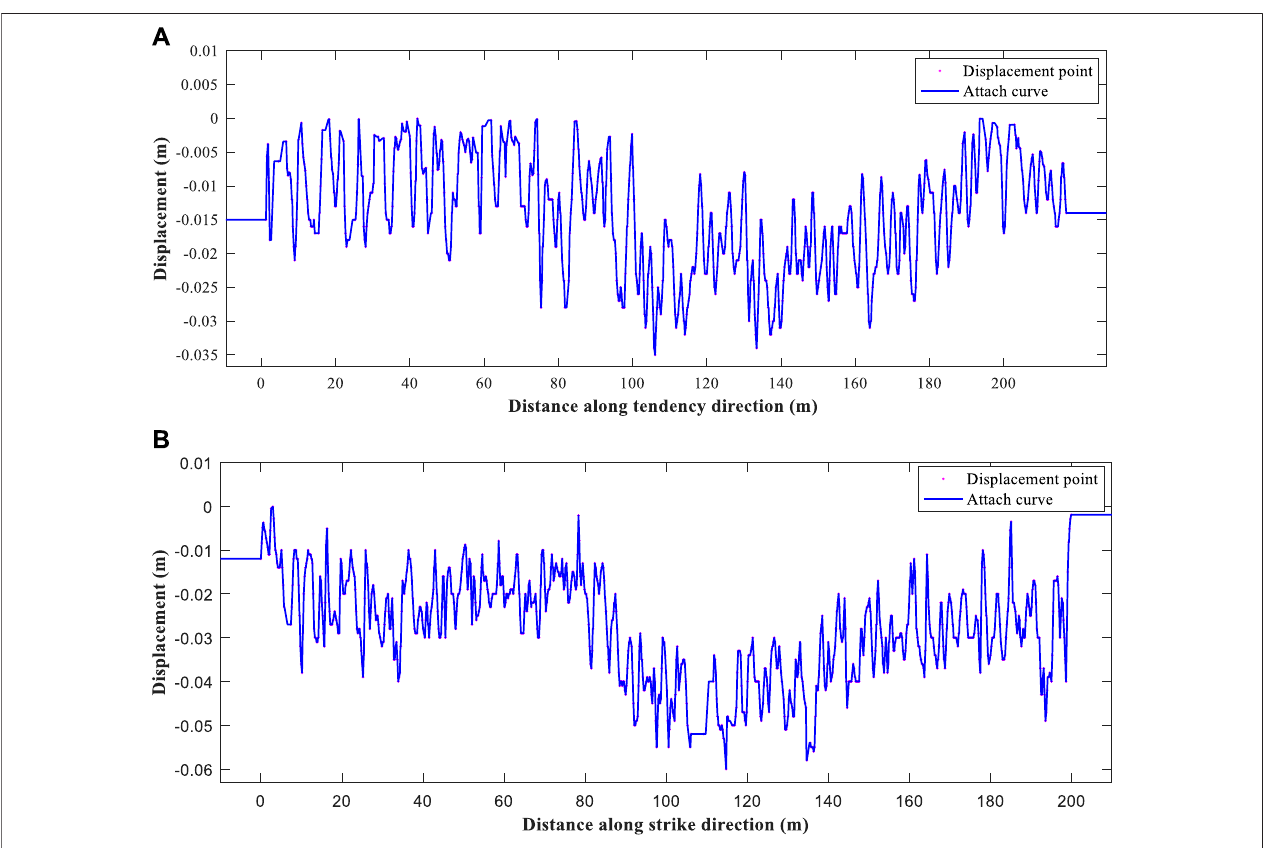
FIGURE 14 | Surface road subsidence value. (A) Subsidence value in the tendency direction (B) Subsidence value in the strike direction.